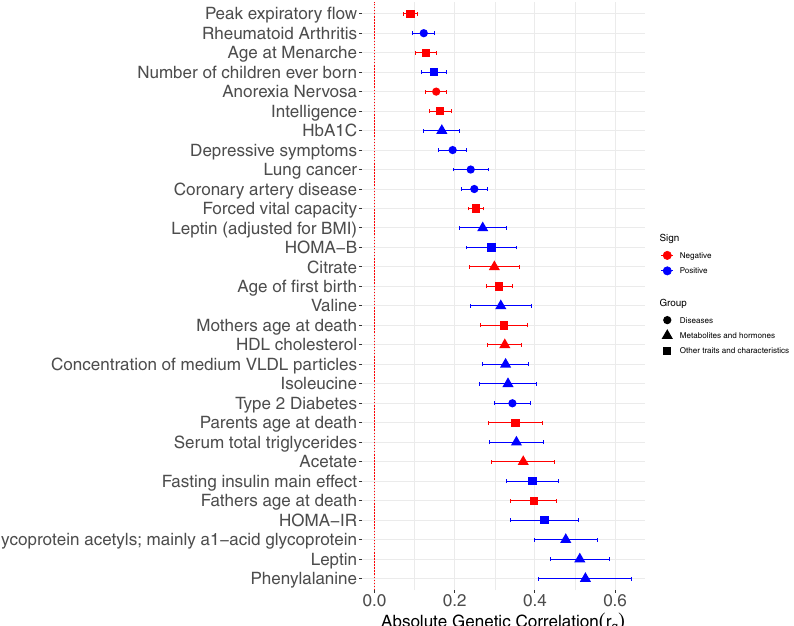
Fig. 4 Cross-trait genetic correlation of traits with CRP. Ordered by group and ascending p value. The error bars correspond to the